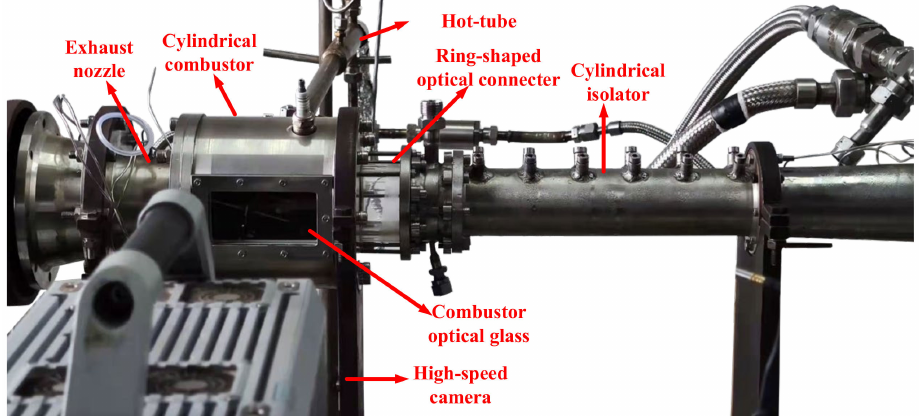
Figure 2. Photograph of the cylindrical air-breathing CRD engine.